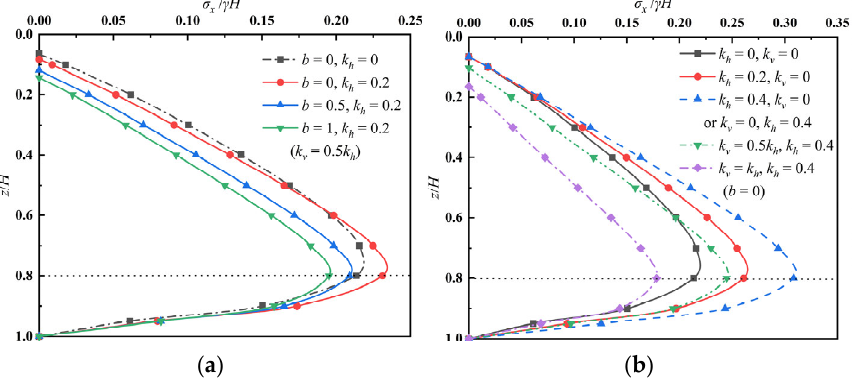
b σ  ; ( b ) k σ  and x h x